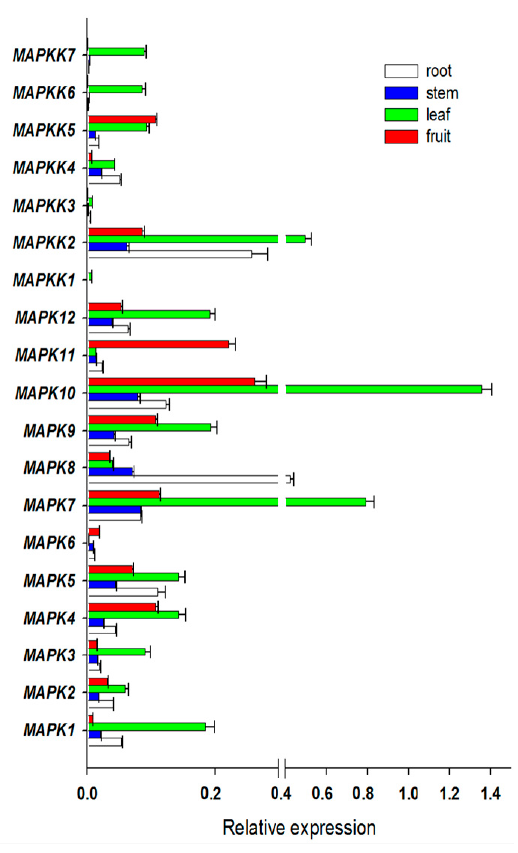
Figure 4. Expression patterns of FvMPKs and FvMPKKs in different organs. X-axis is the relative expression, while Y-axis is MAPK and MAPKK genes; white box, root; blue box, stem; green box, leave; red box, fruit.